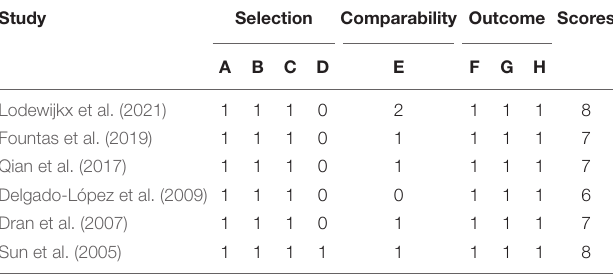
TABLE 1 | Quality assessment by the Newcastle Ottawa Scale for cohort studies.